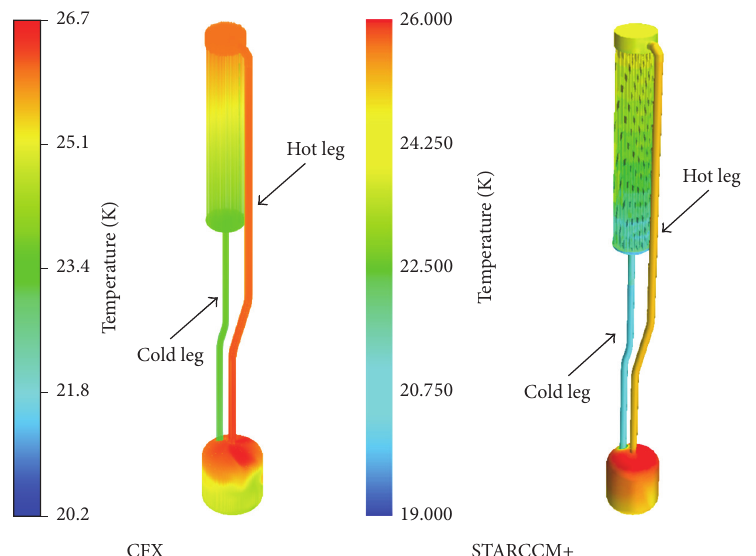
Figure 4: Natural convection flow of liquid deuterium through the “hot leg” and “cold leg” within the closed circulation loop of the CNS thermosiphon system represented by the predicted temperature.